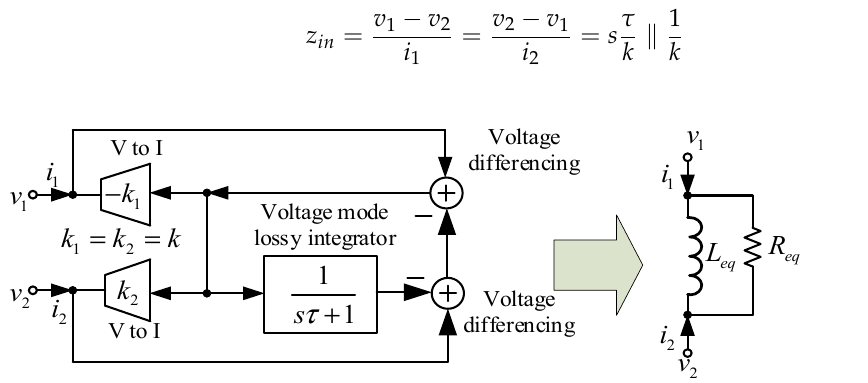
Figure 17. Block diagram demonstrating the synthesis of the floating parallel inductance-resistance simulator.